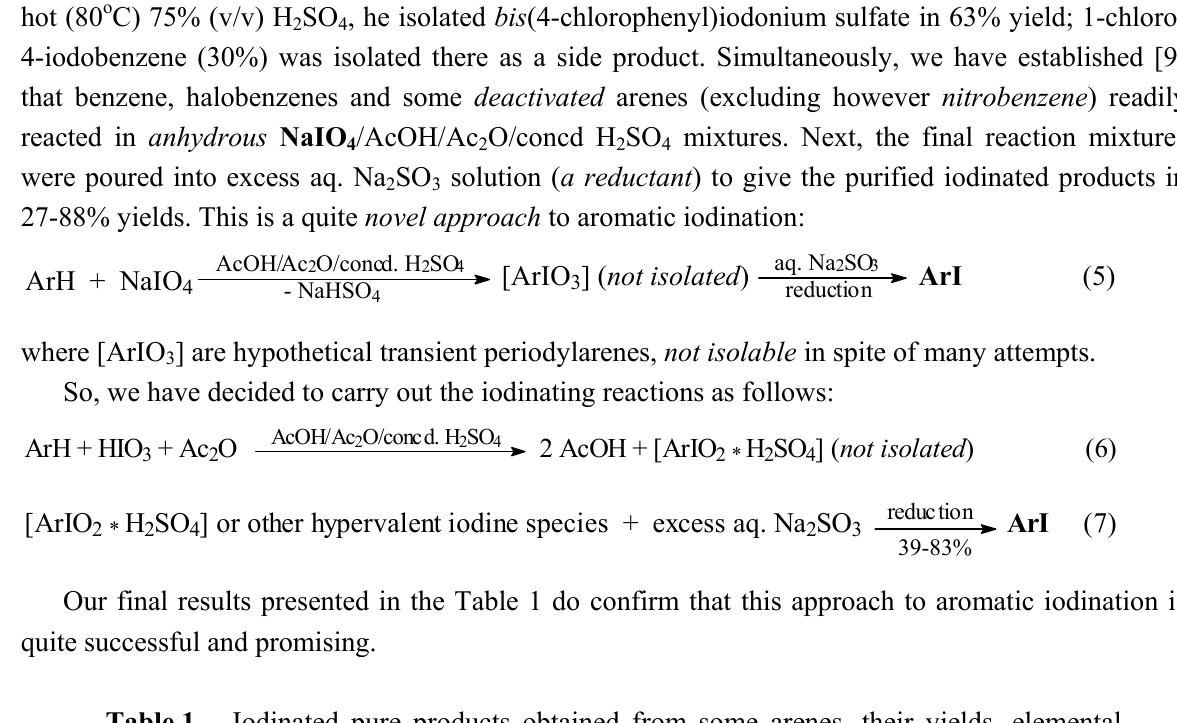
Table 1. Iodinated pure products obtained from some arenes, their yields, elemental analyses, and melting or boiling points